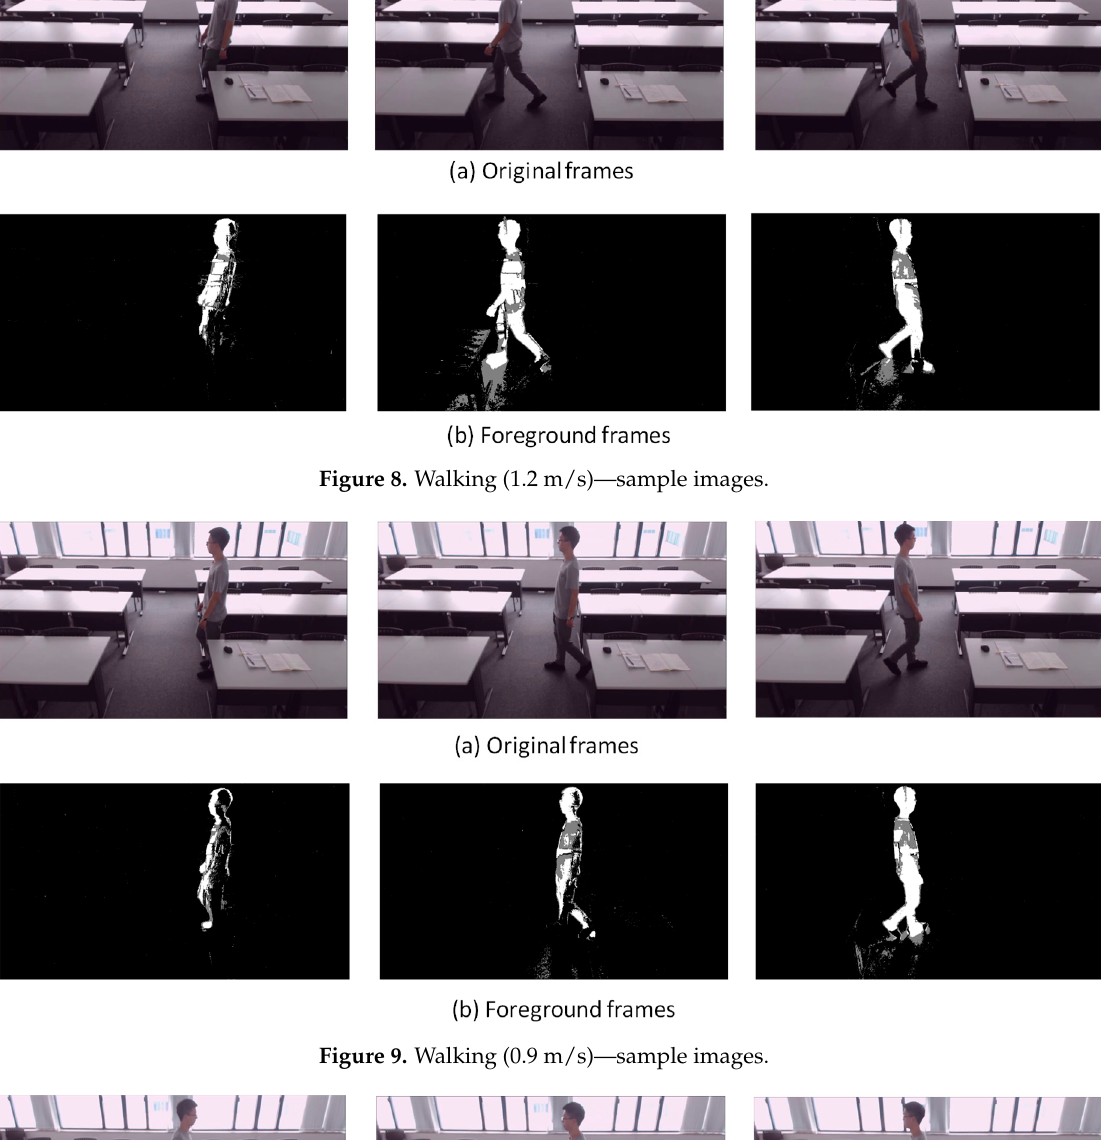
Figure 7. Walking (1.8 m/s)—sample images.